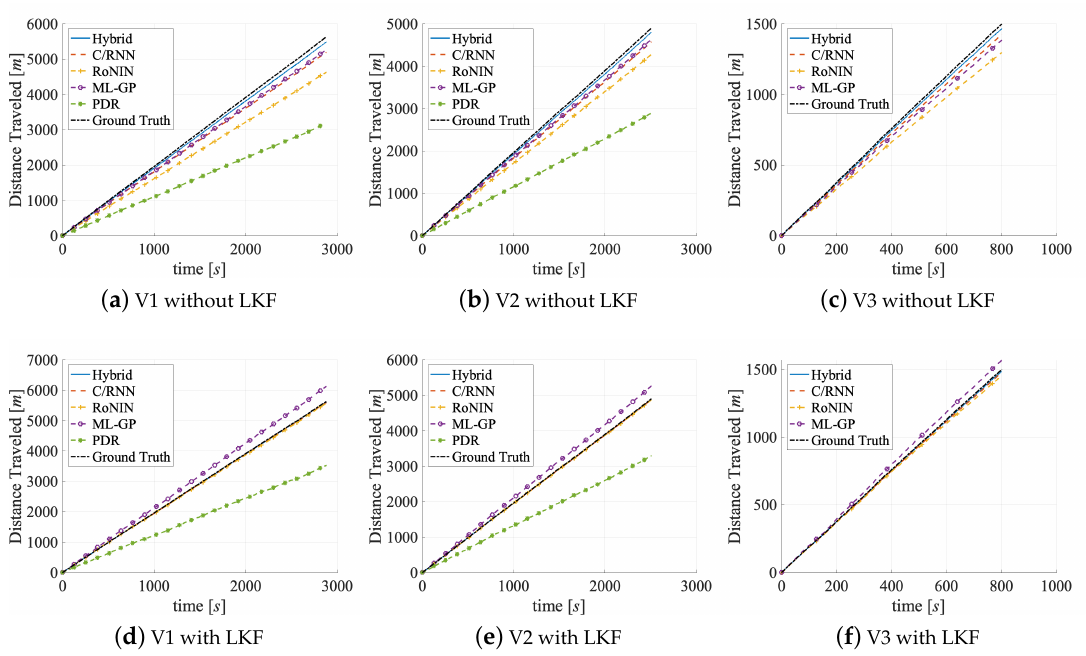
Figure 11. Distance error total (DET) over time on the test sets V1–V3, both without and with